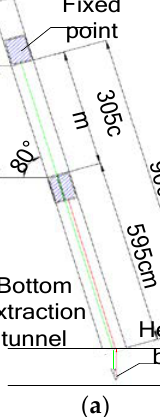
NO. 2 measuring point permeability coefficient test data.